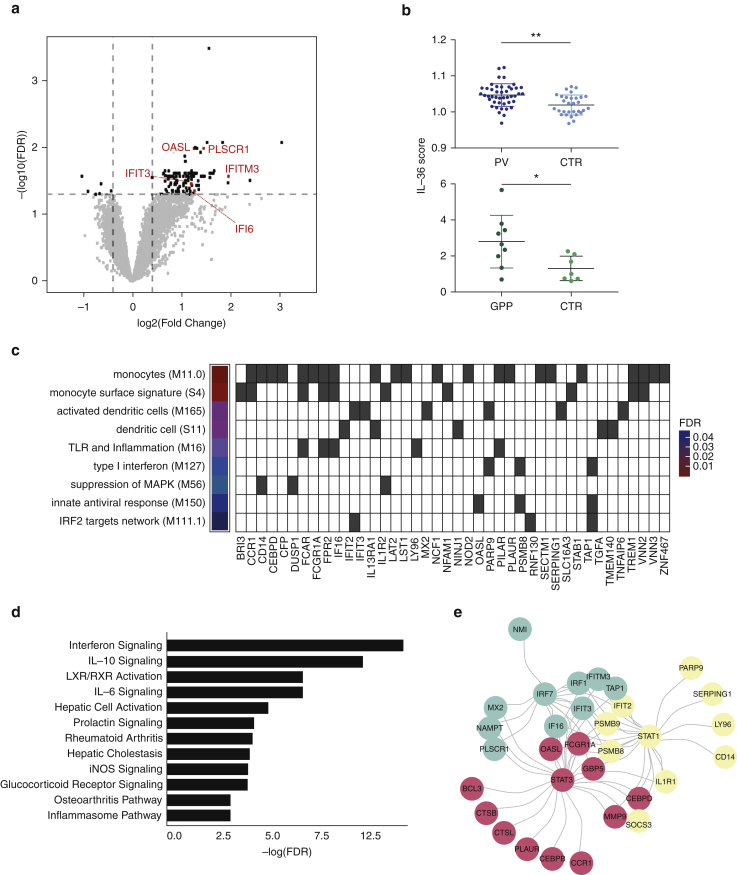
Transcription profiling of GPP and PV whole blood uncovers a IFN-I signature that correlates with IL-36 activity. (a) Identification of genes that are differentially expressed in GPP. Horizontal and vertical lines represent significance and fold change thresholds, respectively. The genes underlying the IFN score are in red. (b) Higher expression of IL-36 dependent genes in whole blood of patients with GPP and PV, compared with controls. (c) Transcriptional modules enriched among genes upregulated in GPP. The FDR for each module is reported, with the underlying upregulated genes shown as gray cells. (d) Enriched pathways detected among genes over-expressed in GPP. (e) Key transcriptional factors driving gene over-expression in GPP. (f) Overlap between the genes that are upregulated in GPP and IFNpathies. (g) Elevated IFN score in whole-blood samples of patients with GPP and PV, compared with controls. (h) IL-36 and IFN scores are significantly correlated, in both patients with GPP and PV. Dashed regression lines are plotted with 95% confidence intervals (gray areas). The data in (b) and (g) are presented as mean ± SD; *P < 0.05, **P < 0.01 (unpaired t test). CTR, control; FDR, false discovery rate; GPP, generalized pustular psoriasis; iNOS, inducible nitric oxide synthase; MAPK, mitogen-activated protein kinase; PV, psoriasis vulgaris; SD, standard deviation; TLR, toll-like receptor.